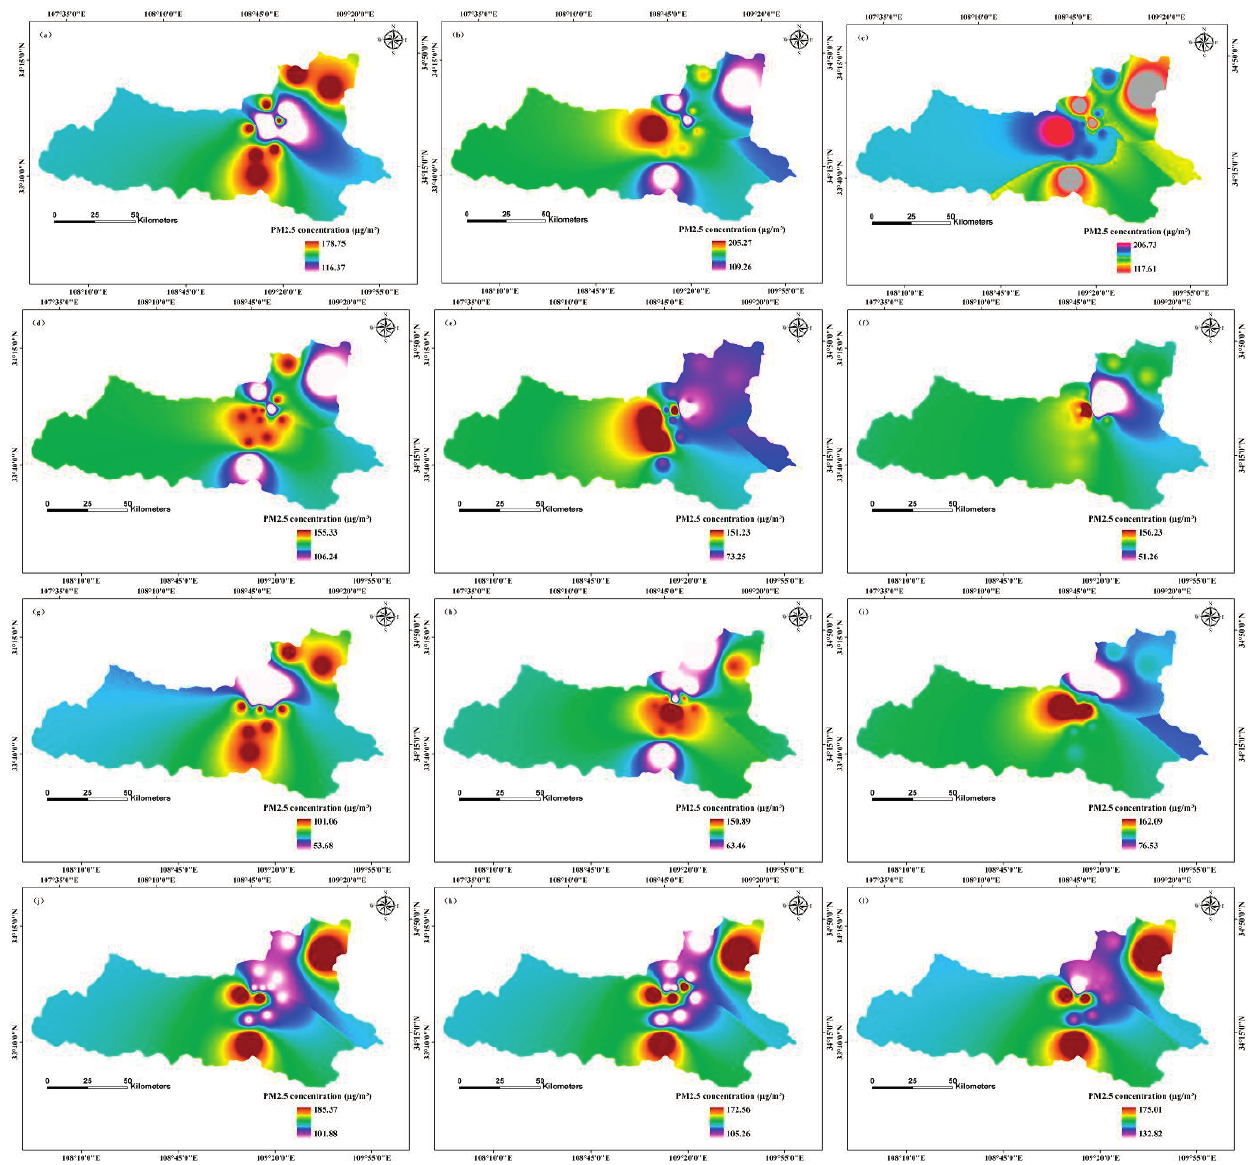
Figure 4. Simulation of temporal and spatial changes of PM2.5 concentration based on a BP-ANN model in 2020, Xi’an, China by month: ( a ) January; ( b ) February; ( c ) March; ( d ) April; ( e ) May; ( f ) June; ( g ) July; ( h ) August; ( i ) September; ( j ) October; ( k ) November; ( l )